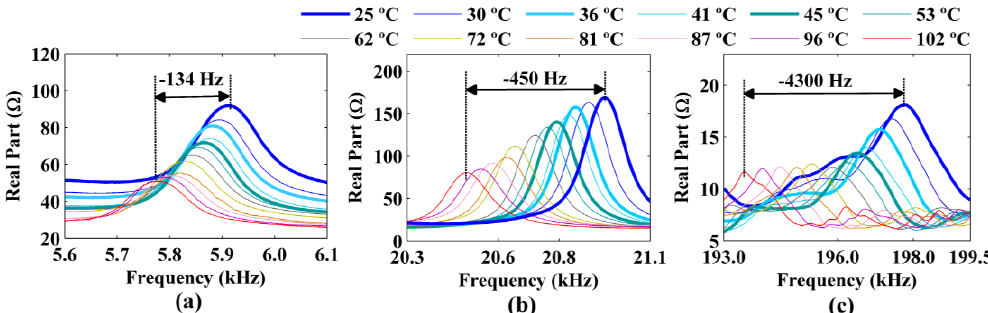
Figure 10. Frequency shifts of the real part of the impedance signatures for resonance peaks at ( a ) 5.91 kHz; ( b ) 20.95 kHz; and ( c ) 197.80 kHz considering the temperature at 25 °C as a reference.